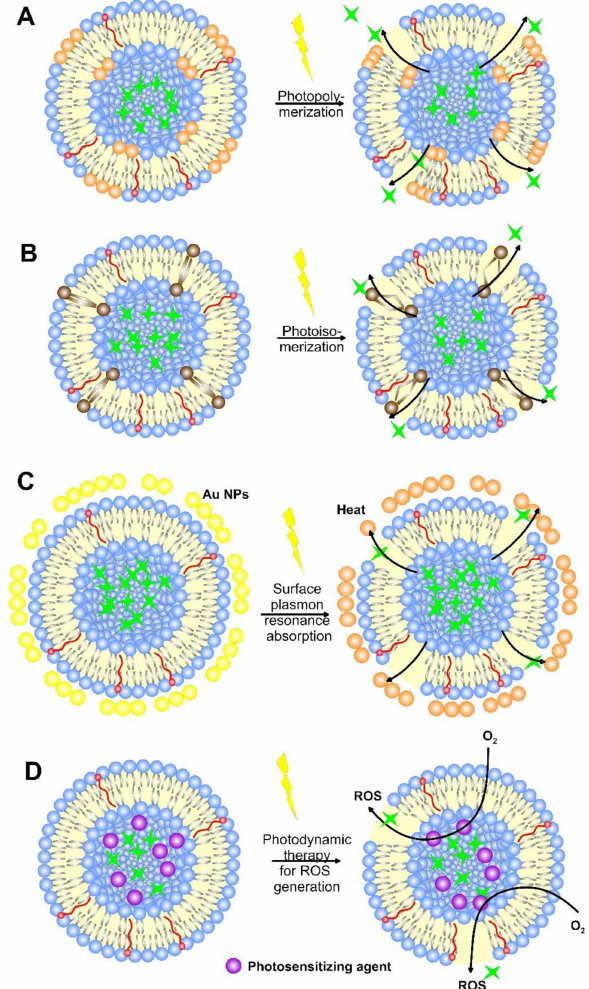
Figure 11. Schematic representation of different mechanisms of drug release by light-responsive lipo- somes: ( A ) photopolymerization; ( B ) photoisomerization; ( C ) surface plasmon resonance absorption; ( D ) photodynamic therapy for generation of reactive oxygen species